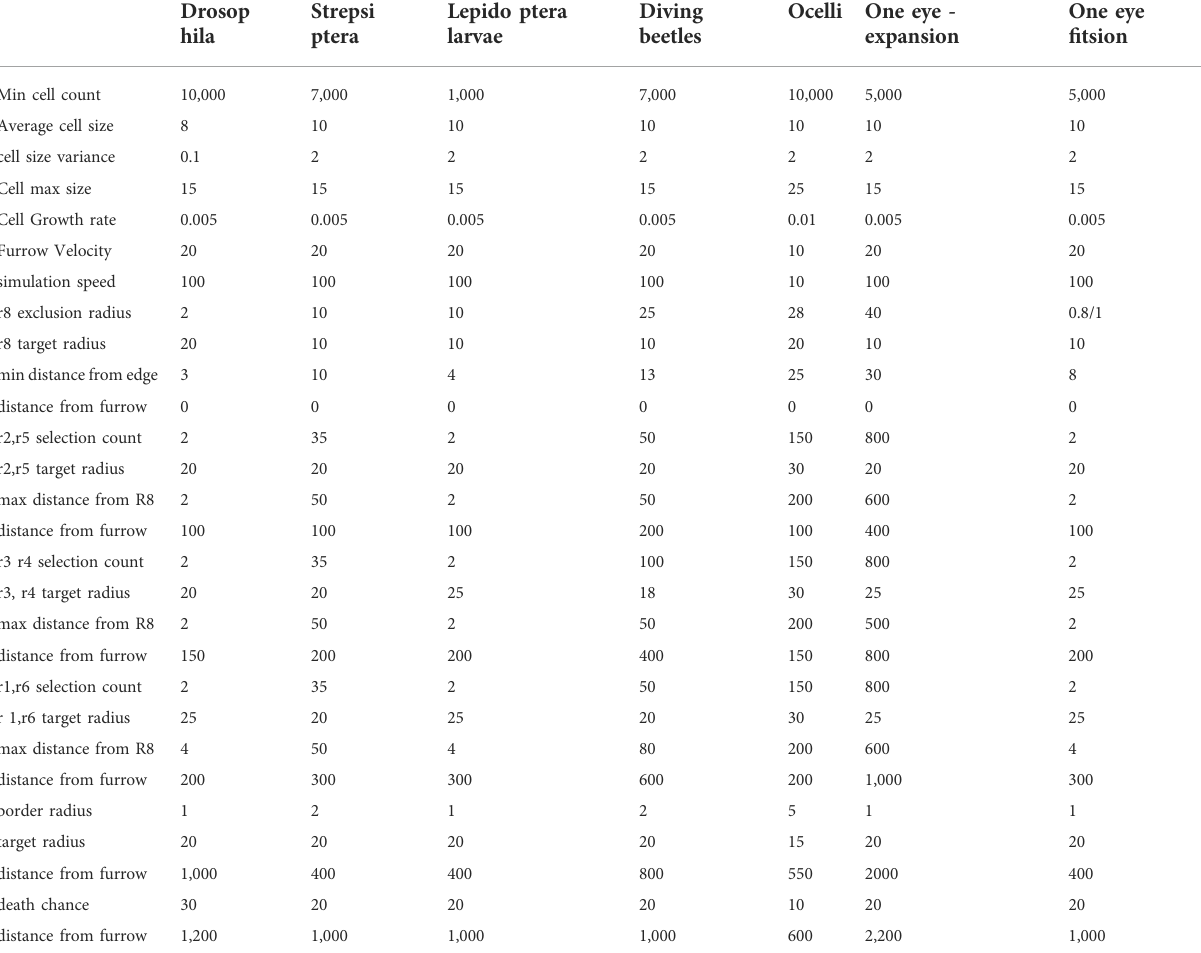
TABLE 1 Input parameters used by EyeVolve to produce the layouts illustrated in Figures 2 –